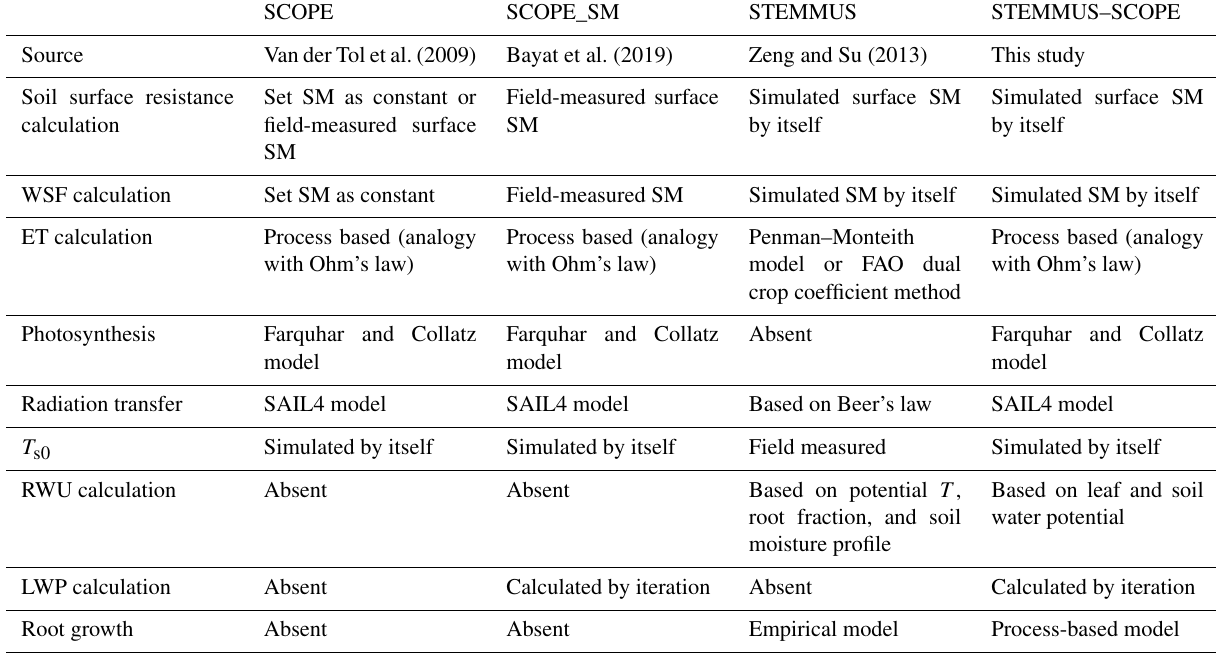
Table 2. Main differences among SCOPE, SCOPE_SM, STEMMUS, and STEMMUS–SCOPE. The reader is referred to Table B1 in the Appendix for a description of the abbreviations used in this